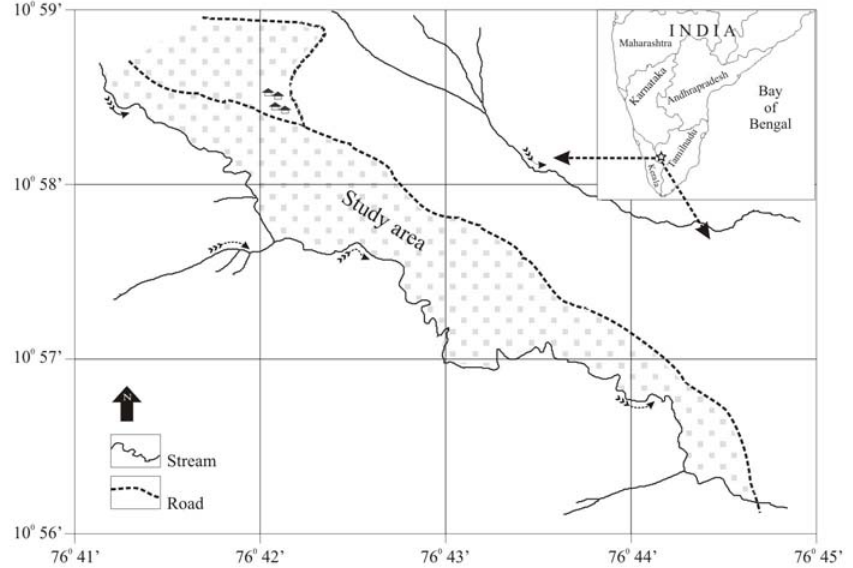
FIGURE 1. Map of the study